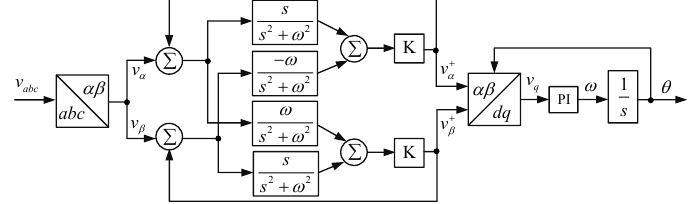
Figure 24. Multiple